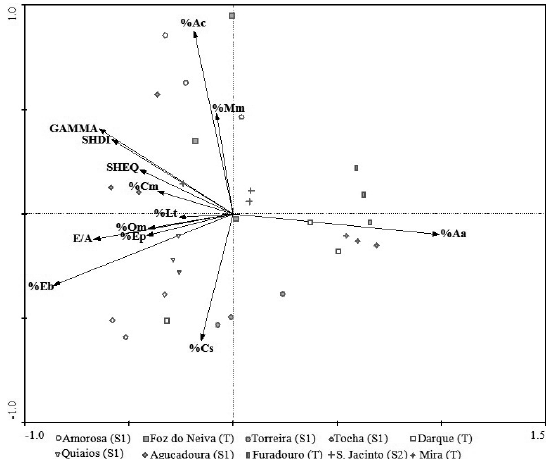
Figure 6. Redundancy analysis (RDA) diagram of vegetation pro- files, with quantitative attributes of diversity represented on the ordination space (see Table 1 for codes of diversity attributes and Appendix 1 for codes of plant